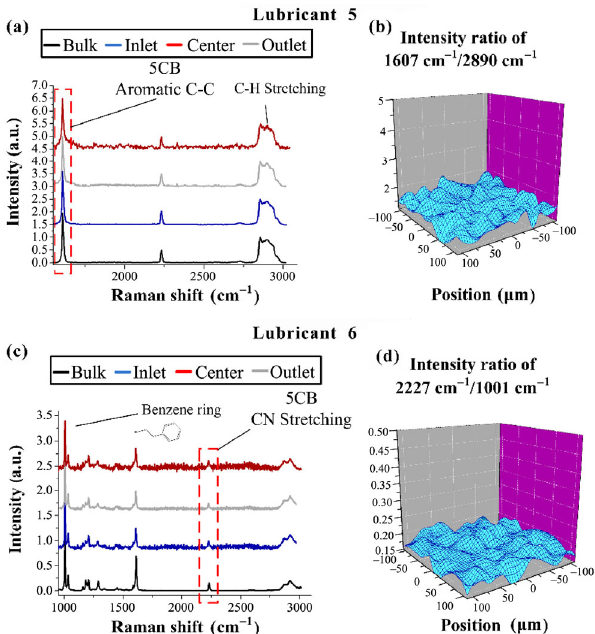
Fig. 4 Molecular distribution of Lubricant 5 and 6. (a) and (c): in situ Raman spectral results at the four areas and the molecular structures of two components; (b) and (d): in situ profile of the intensity ratio of additive molecule to base oil.